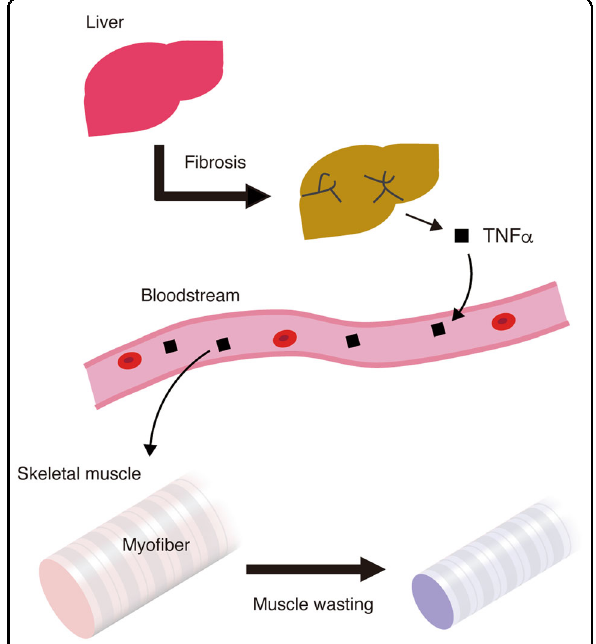
Fig. 7 Inter-organ communication mechanism that underlies the pathogenesis of liver fi brosis-induced muscle atrophy. TNF α released from the fi brotic liver, which is delivered to the skeletal muscle through the blood, promotes myo fi ber